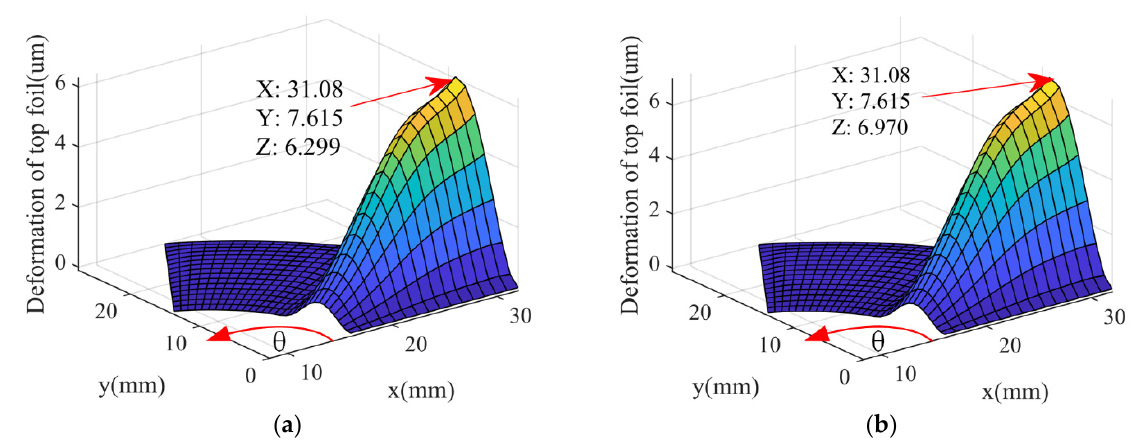
Figure 8. Deformation distribution of top foil under different thermal model. ( a ) Isothermal model; ( b ) THD model.